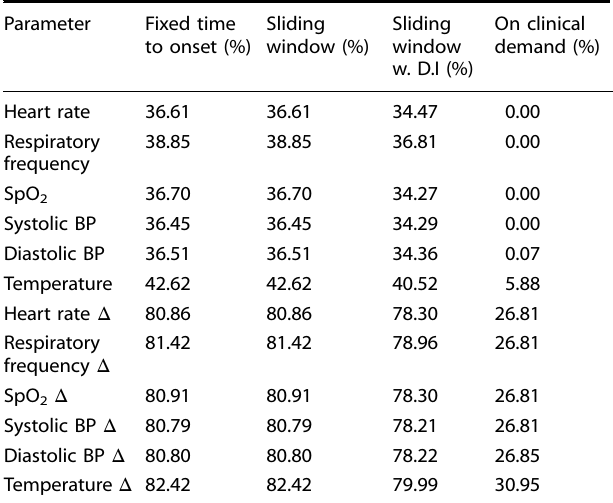
The results from Table 2 show that no one MLRP model was superior on all points. There was a tendency toward speci fi c models dominating speci fi c evaluations metrics. For example, extra trees had the best ACE score for all four framing structures. Similarly, random forest had the best Brier score for the positive cases for all framing structures. These fi ndings highlight the importance of clarifying the most important evaluation metric for each case and then testing different ML algorithms to fi nd the one that optimizes the speci fi c metric of interest. Take the case of dementia risk prediction, where a recent study evaluated the calibration of MLRP models to predict the risk of developing dementia the authors found that the models signi fi cantly over- estimated the risk of developing dementia. At a predicted risk of 40%, the observed risk was only 10% — an overestimation of 30%.